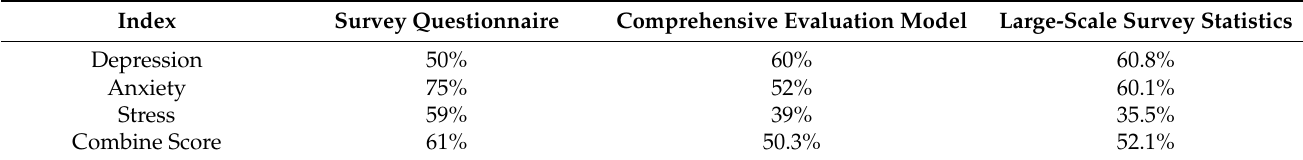
Table 4. Comparison of a single mental health questionnaire, a comprehensive facial emotion recognition model, and statistical results from a large-scale graduate student mental health